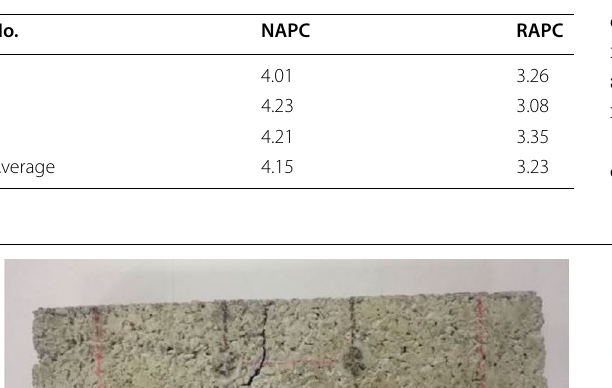
Table 3 Static four-point bending strength for pervious concrete (MPa).